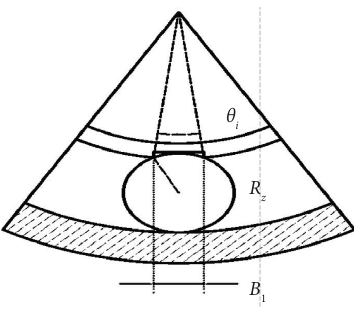
Figure 11: Inner race